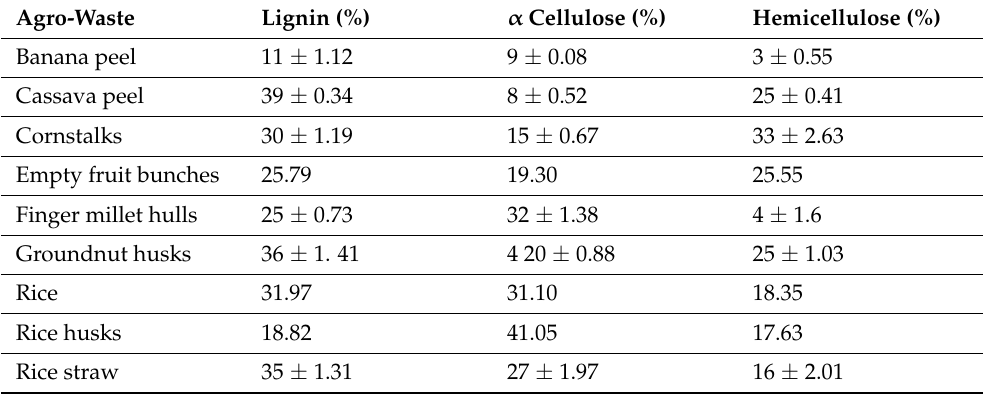
Table 1. Major component percentages of common